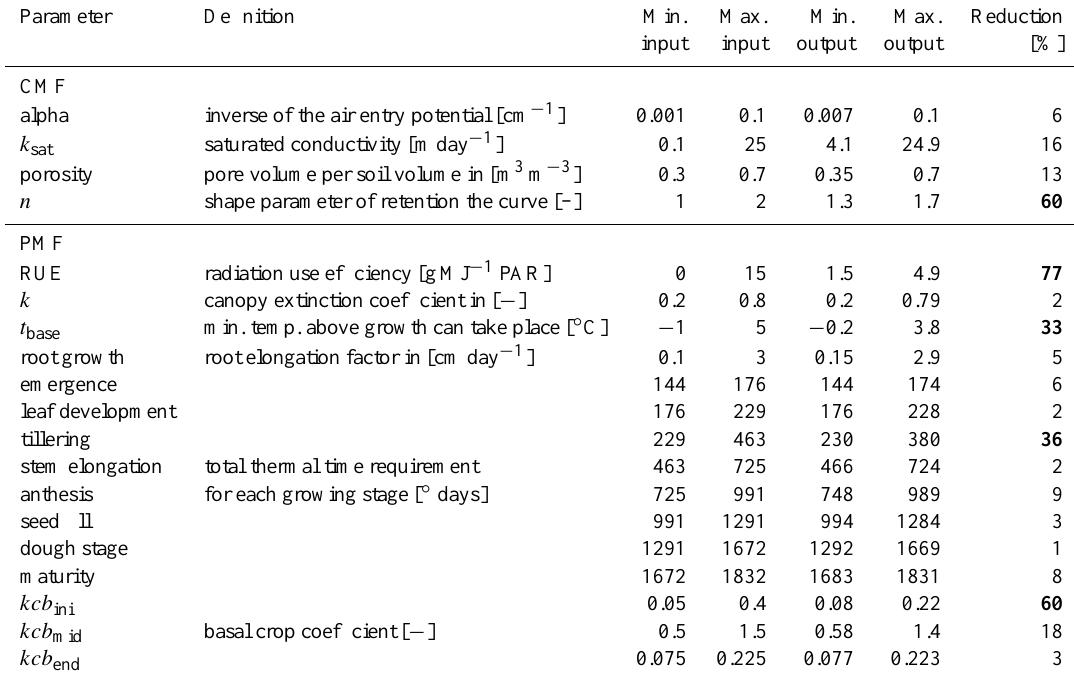
Table 1. Parameter ranges of the Monte Carlo simulation for the coupled CMF–PMF for site 1 in Müncheberg. PAR stands for photosyn- thetically active radiation. Minimal to maximal input is the range for the GLUE analysis, while the output is the constrained range of the observed behavioural parameter sets (cf. Figs. 2 and 3). Uncertainty reduction in the output over 30% is reflected in bold type. Parameter Definition